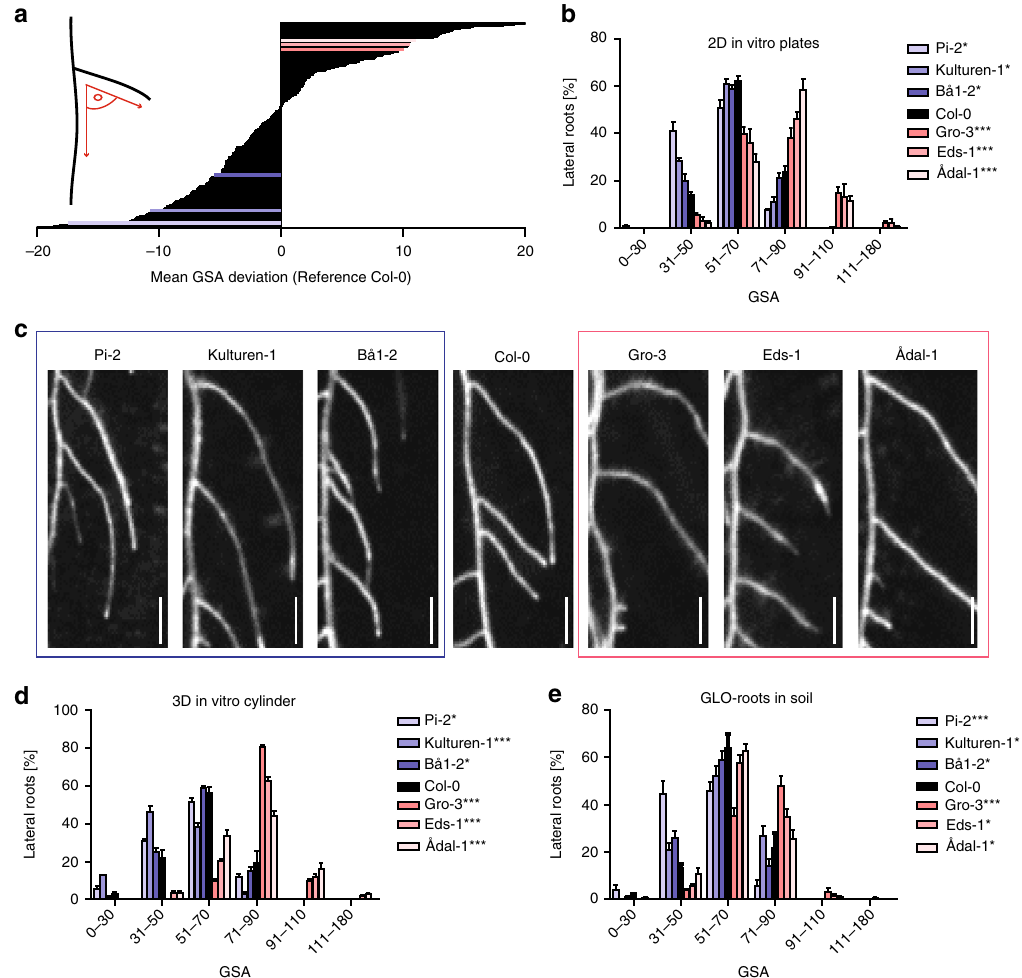
Fig. 1 Natural variation of the primary GSA of lateral roots in Arabidopsis thaliana . a Mean gravitropic set point angle (GSA) values are normalized to reference accession Col-0 . Three hyper-responsive (blue colors) and hypo-responsive (red colors) accessions were selected for further analysis. b GSA distributions of hyper-responsive and hypo-responsive accessions grown on 2D agar plates. n = 5 plates (16 seedlings with 30 – 120 LRs per plate). c Representative images of hyper-responsive and hypo-responsive accessions grown on 2D agar plates. Scale bars, 20 mm. d GSA distribution of hyper- responsive and hypo-responsive accessions grown in 3D agar cylinders. n = 5 cylinders (25 – 120 LRs per cylinder). e GSA distribution of hyper-responsive and hypo-responsive accessions grown in soil. n = 5 – 10 plants (25 – 75 LRs per plant). b , d , e Kolmogorov – Smirnov test P -values: * P < 0.05, ** P < 0.01, *** P < 0.001 (compared to Col-0 ). Mean ± SEM. Experiments were repeated at least three the CK receptor mutants (Fig. 2g, Supplementary Data 2). This set of data suggests that CK signaling de fi nes directional lateral root growth by reducing LR bending after emergence.